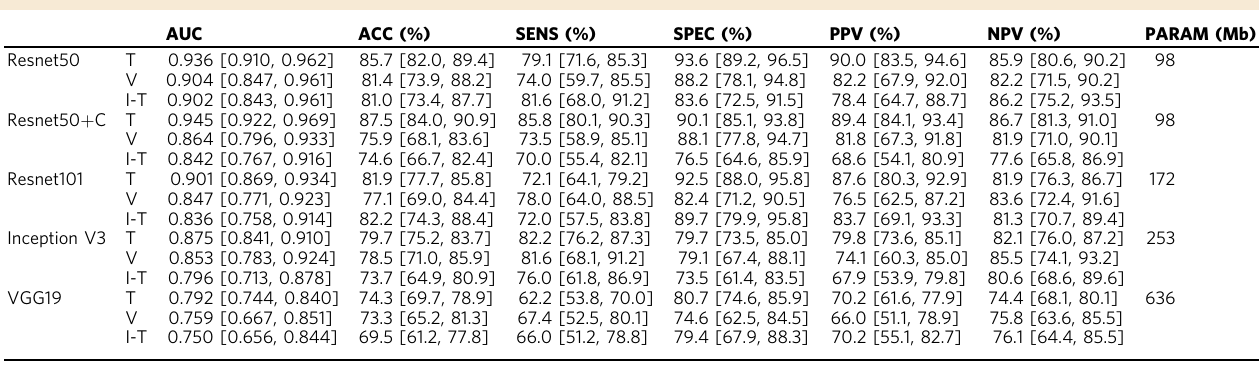
Table 1 The performance comparison of different